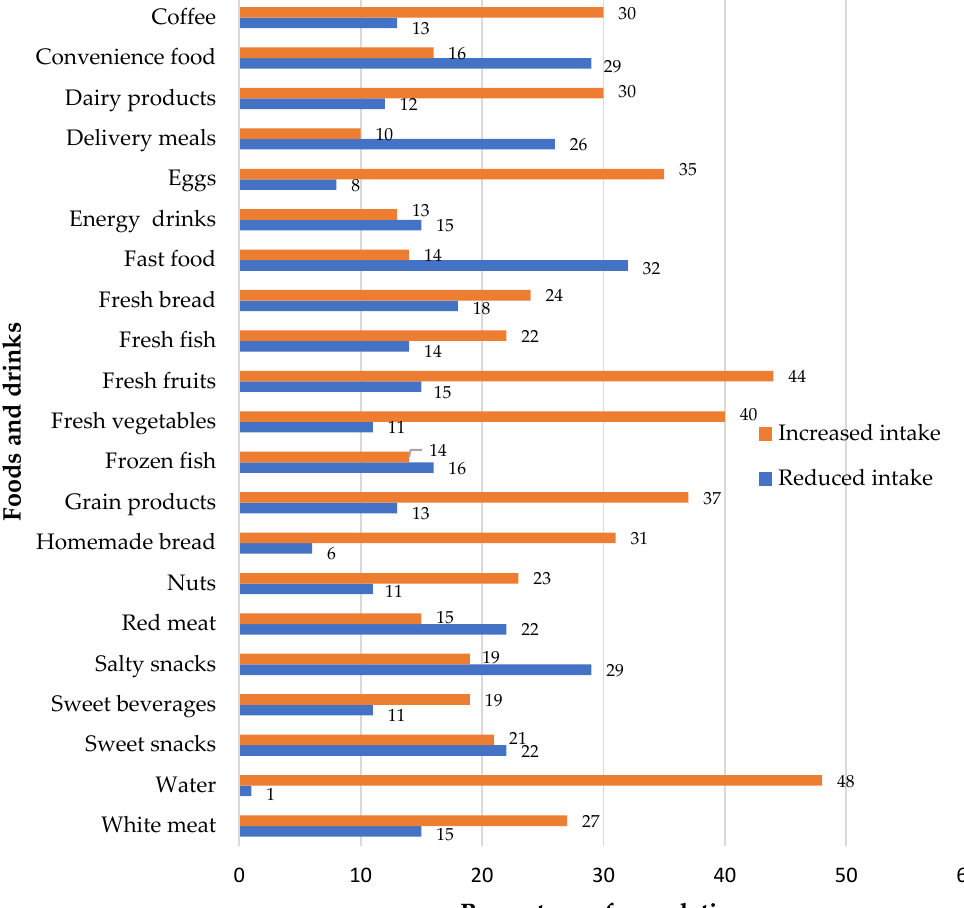
Figure 2. The impact of the COVID-19 pandemic on food and drink intake according to respondents’ responses.